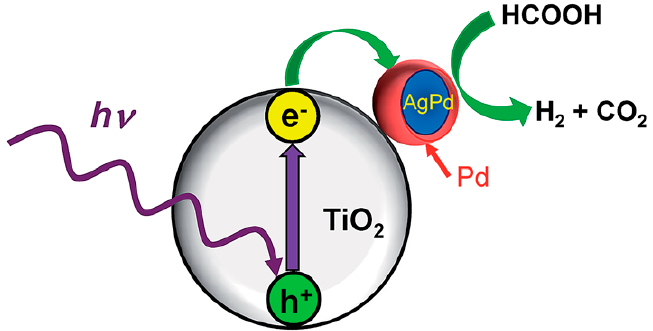
Figure 8. Enhancement mechanism of catalytic activity of AgPd@Pd/TiO 2 under UV and Vis photoirradiation. Reprinted with permission from [96].